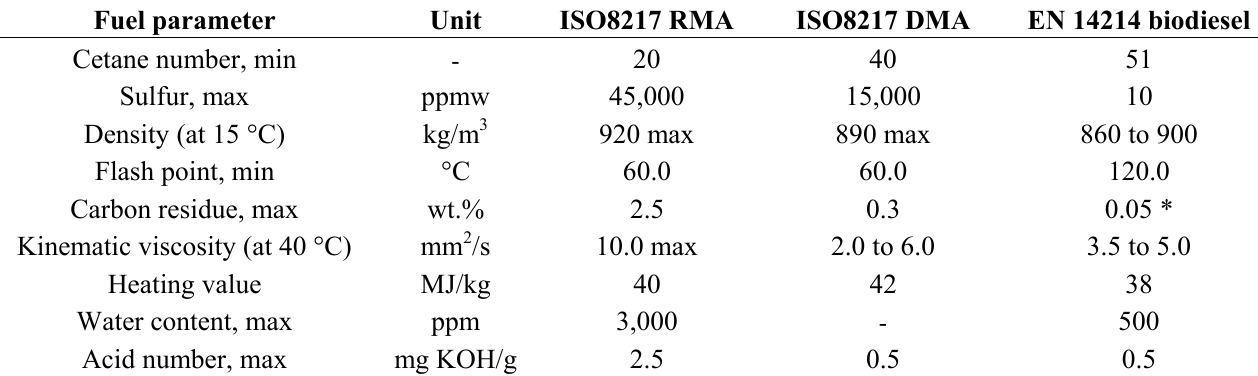
Table 1. Fuel properties of the specification ISO 8217 RMA for residual marine fuel and DMA for distillate marine fuel and the specification EN 14214 for